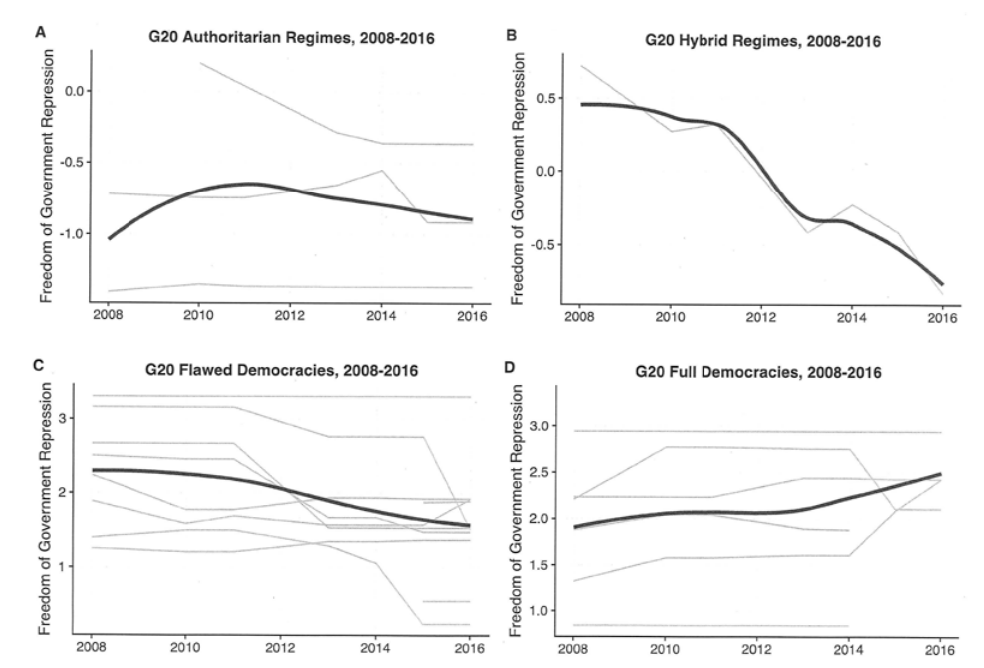
Figure 2: Government